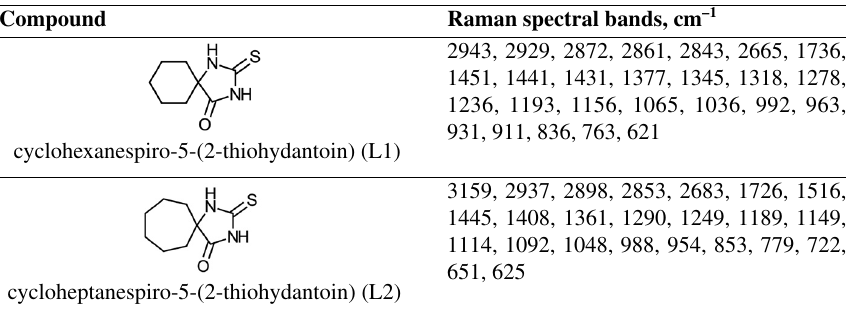
Table 2. Raman spectral data of free ligands L1 and L2